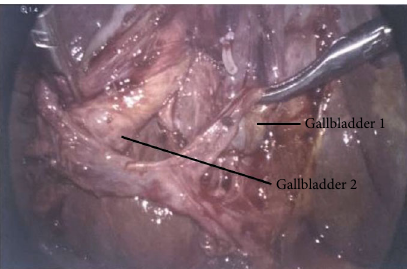
Figure 4: Two separate gallbladders after incomplete cystic duct dissection.